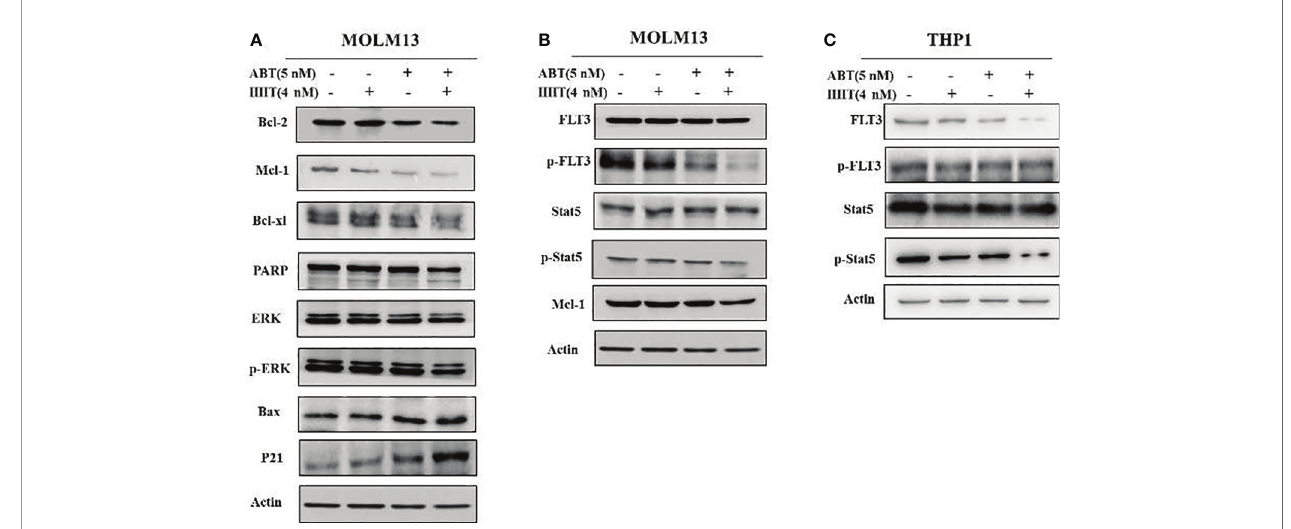
FIGURE 5 | In the MOLM-13 cell lines, compared with each agent alone, ABT-199 combined with HHT downregulated MCL-1, p-ERK expression (A) . Strikingly, our results also showed that cotreatment with ABT-199 and HHT inhibited the FLT3/Stat5/MCL-1 signaling cascade, and the protein levels of p-FLT3, p-Stat5, and MCL-1 were determined by Western blotting (B) . The total and phosphorylation protein of FLT3 and STAT in a FLT3 ITD-negative cell line were shown by Western blot (C)